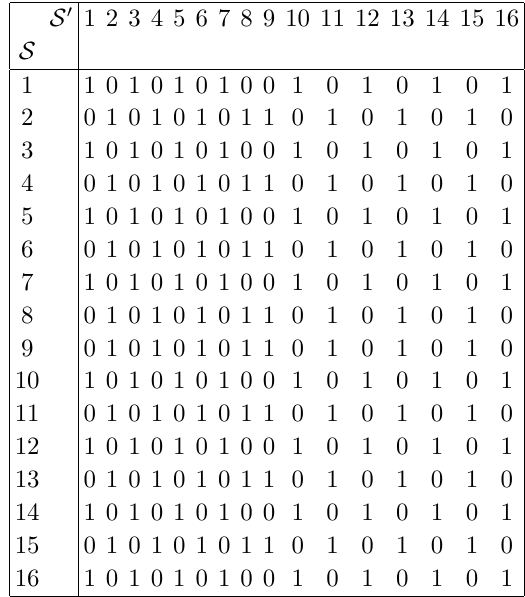
Table 28 . Gadget values for P